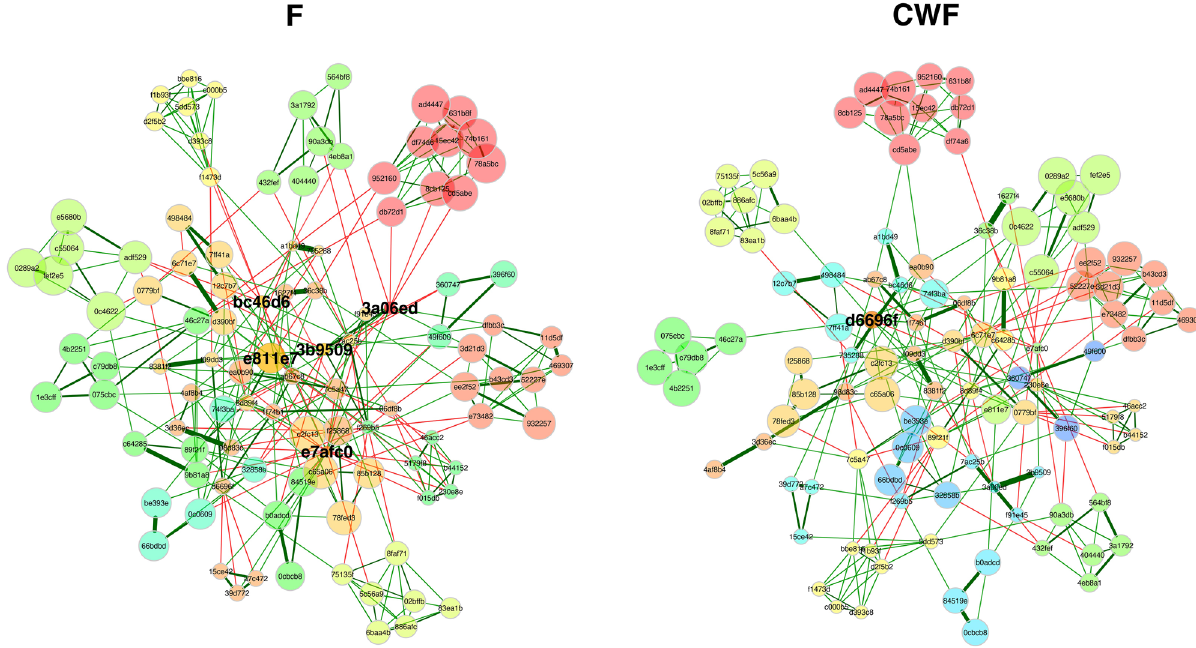
Figure 8. F and CWF microbial networks obtained by using the NetCoMi framework. Nodes are sized and coloured according to normalized counts and cluster membership. Edges color reflects the correlation among nodes (green and red for positive and negative correlations, respectively). In particular, cluster sharing at least 5 nodes among the two networks were plotted using the same colour. Details about node name and taxonomic classification are available in Supplementary Table S6.